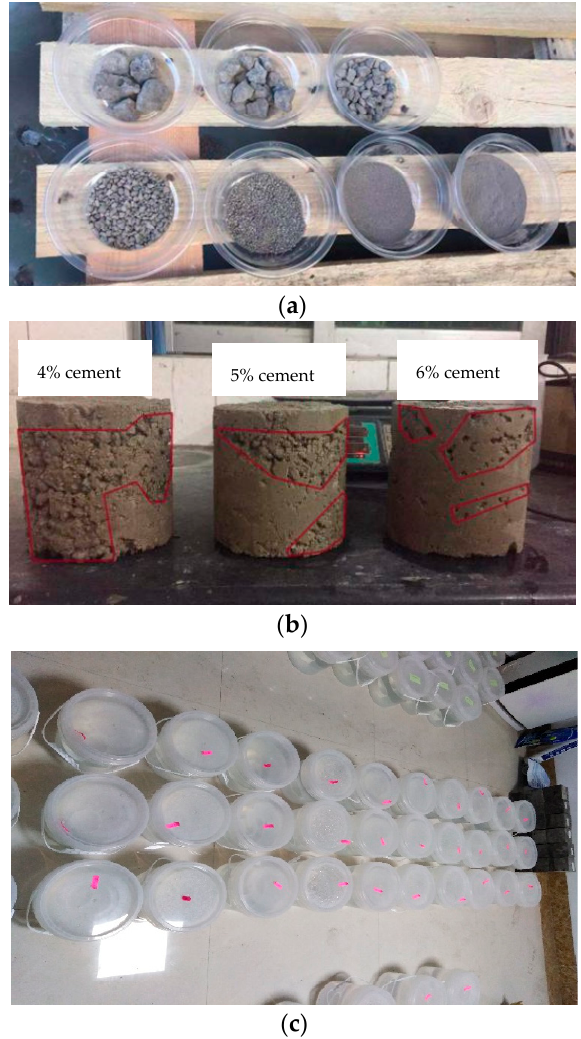
Figure 8. Heavy metal leaching test. ( a ) Steel slag aggregates of different particle size; ( b ) Samples with different cement content; ( c ) Containers with different seawater salinity.